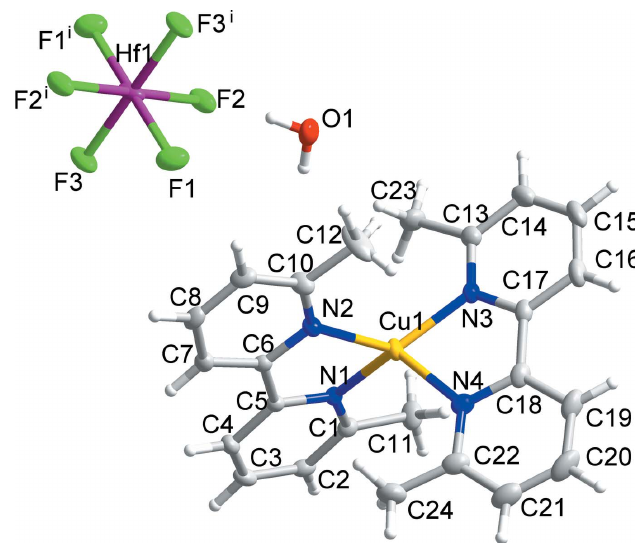
Figure 1 The molecular structure of (I) showing 50% displacement ellipsoids.